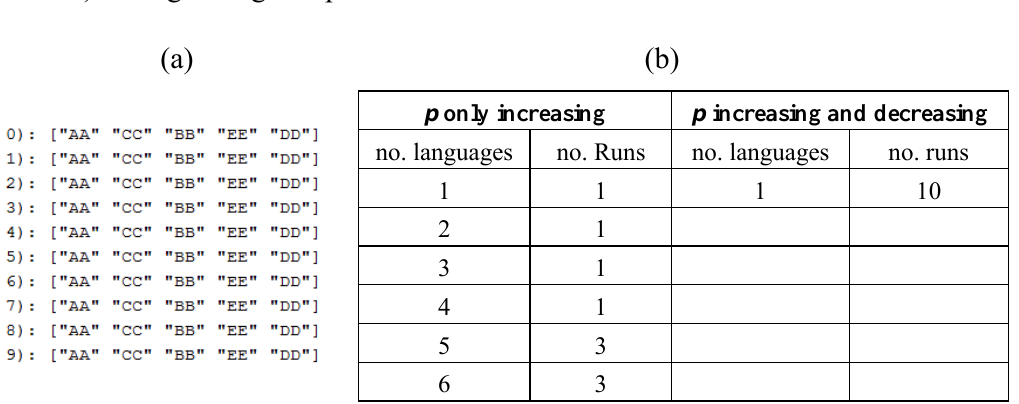
Figure 4. ( a ) Words as “agreed” upon by agents, with the possibility to increase and decrease probabilities ( p = 10, n = 5); ( b ) Results of 2 × 10 test runs, once with the basic version of the model ( p increasing by 1 in the case of a successful interaction), and once with the altered model ( p increasing by 1 in the case of a successful interaction and decreasing by 0.2 in the case of a failed interaction). “no. languages” indicates the number of different languages (or rather “dialects”, since languages usually differ only in one or two words) that agents agree